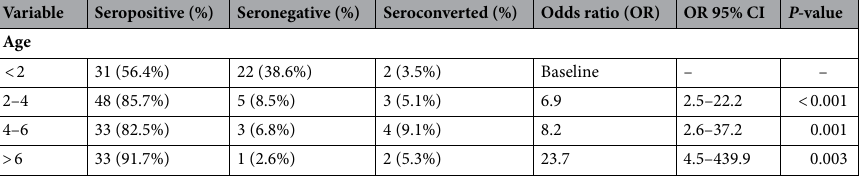
Table 3. Summary of seroprevalence results by koala age group and logistic regression outputs for the analysis of the association of koala age with RRV seroprevalence in koalas residing in coastal lacustrine and estuarine environments. Percentages are calculated for the number of individuals in each row. The data shown is only for animals for which their location could be confirmed (n = 187) after accounting for relocated individuals and animals with too few position locations (n < 5) to confirm their assignment to a particular environment.